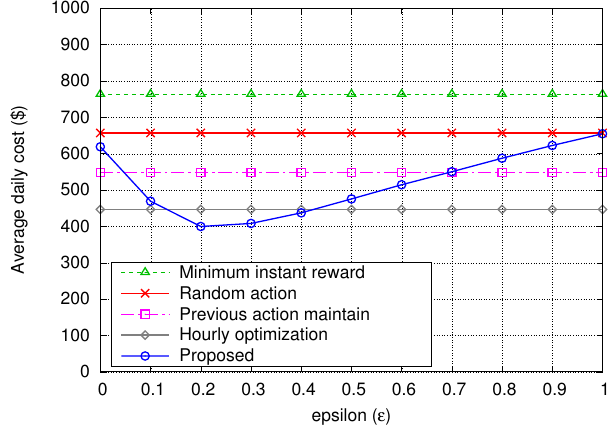
Figure 10. Average daily cost variation with respect to ε -greedy